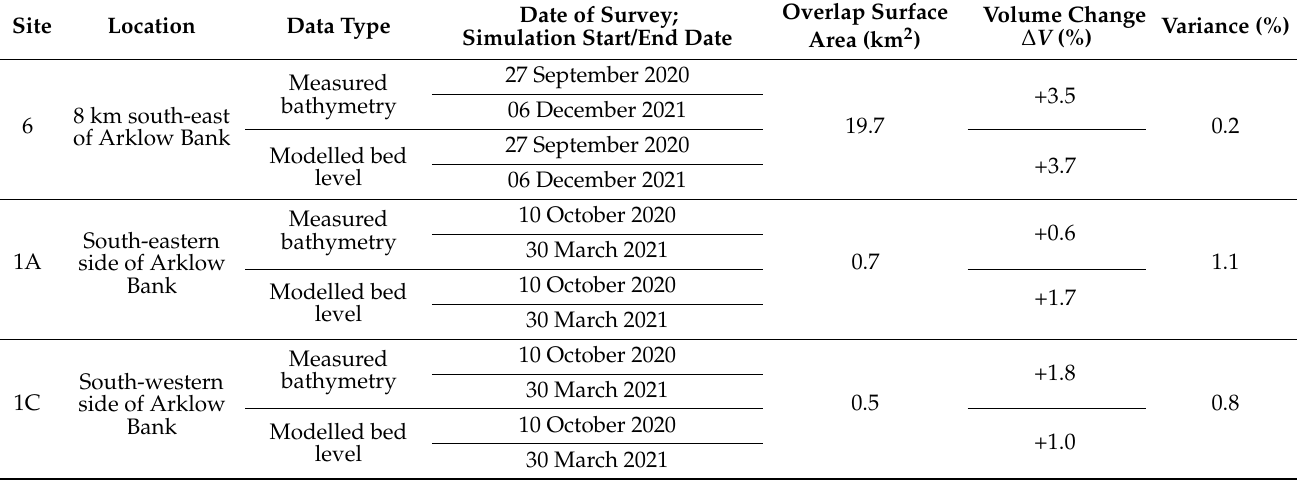
Table 1. Comparison of simulated bed level changes against measured repeat bathymetry datasets at different sites in the model